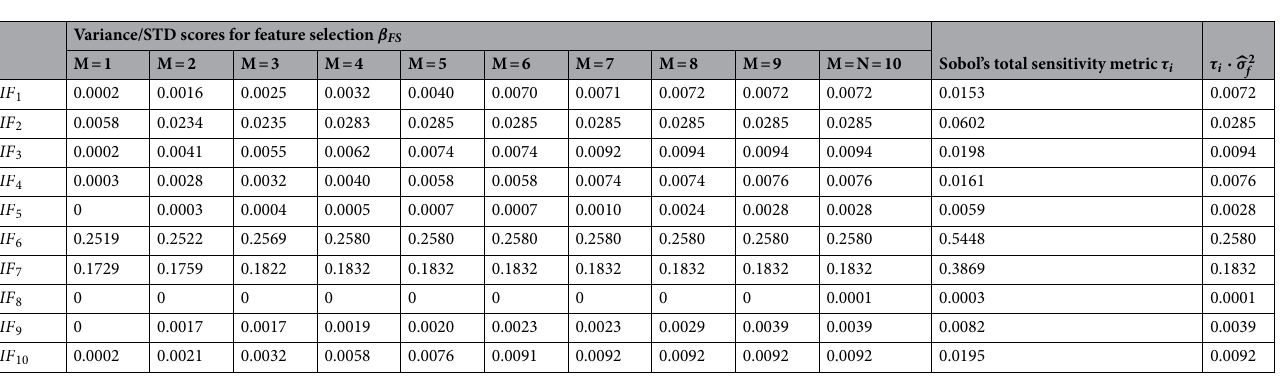
Variance/STD scores for feature selection β FS